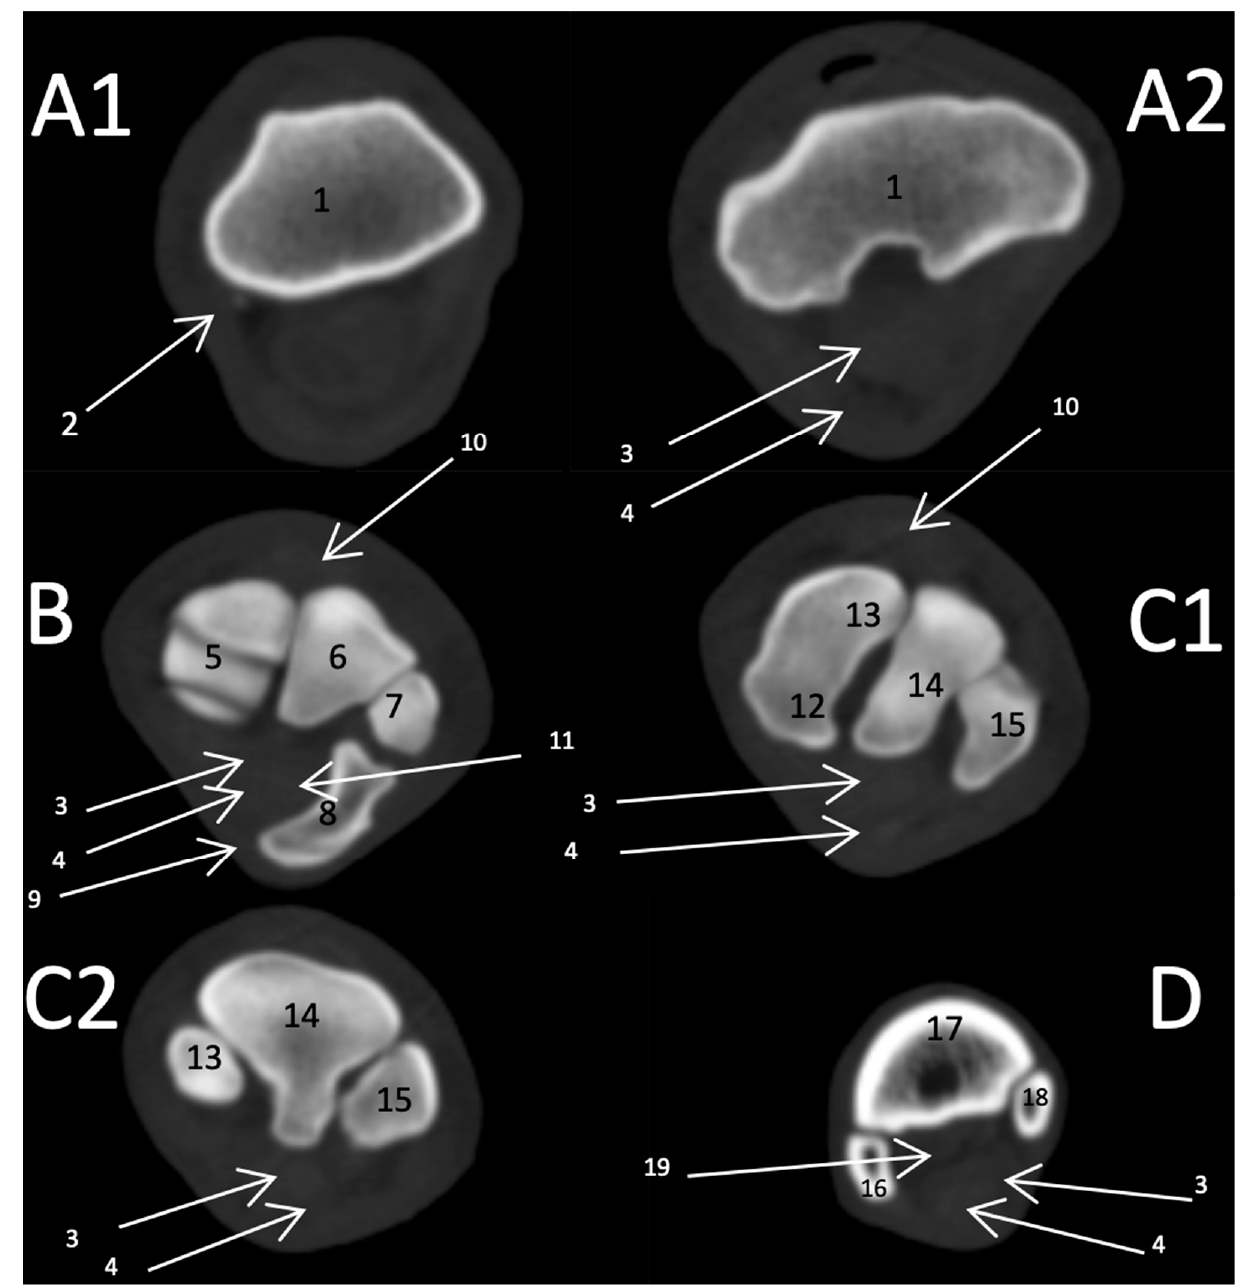
Figure 6. Cross-sectional computed tomographic scan of the carpal joint in donkeys. ( A1 ) (1) Radius. (2) Ulna. ( A2 ) (3) Deep digital flexor tendon. (4) Superficial digital flexor tendon. ( B ) (5) Radiocarpal bone. (6) Intermediate carpal bone. (7) Ulnar carpal bone. (8) Addition carpal bone. (9) Palmar carpal ligament. (10) Common digital extensor tendon. (11) Carpal canal. ( C1 ) (12) First carpal bone. (13) Second carpal bone. (14) Third carpal bone. (15) Fourth carpal bone. ( C2 ) (8) Second carpal bone. (9) Third carpal bone. (10) Fourth carpal bone. ( D ) (16) Fourth metacarpal. (17) Third metacarpal bone with the small bone cysts. (18) Second metacarpal bone with the small bone cysts. (19) Suspensory ligament.